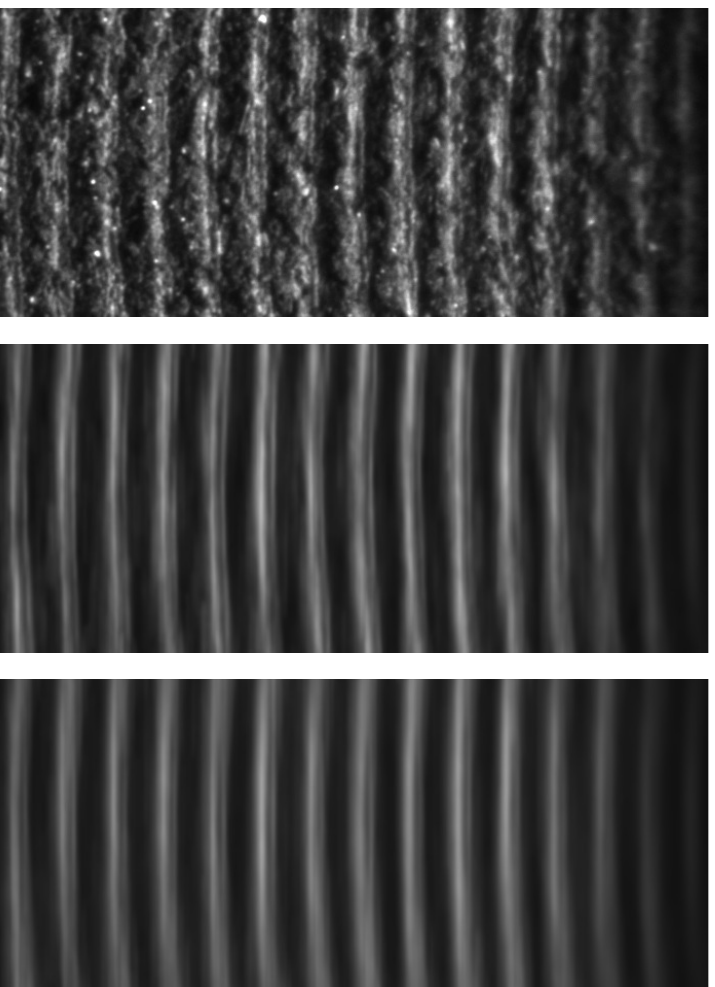
Figure 9. Comparison of the processed images using the expert and the optimized settings: the origi- nal extracted image ( top ), the image processed with expert-defined MV parameter settings ( center ), and the image processed with MV and ML parameters set by the optimization algorithm ( bottom